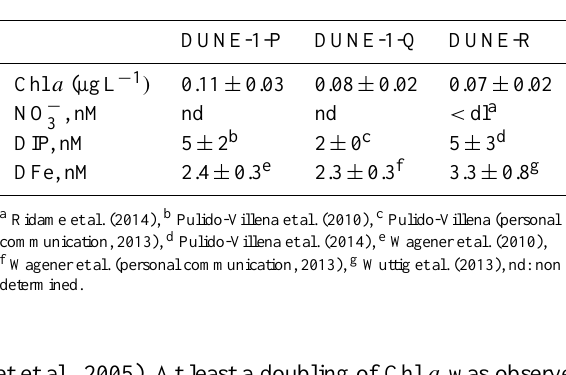
Table 4. Initial conditions of the tested waters during DUNE-P and